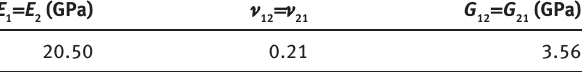
Table 2 Mechanical properties of specimens.